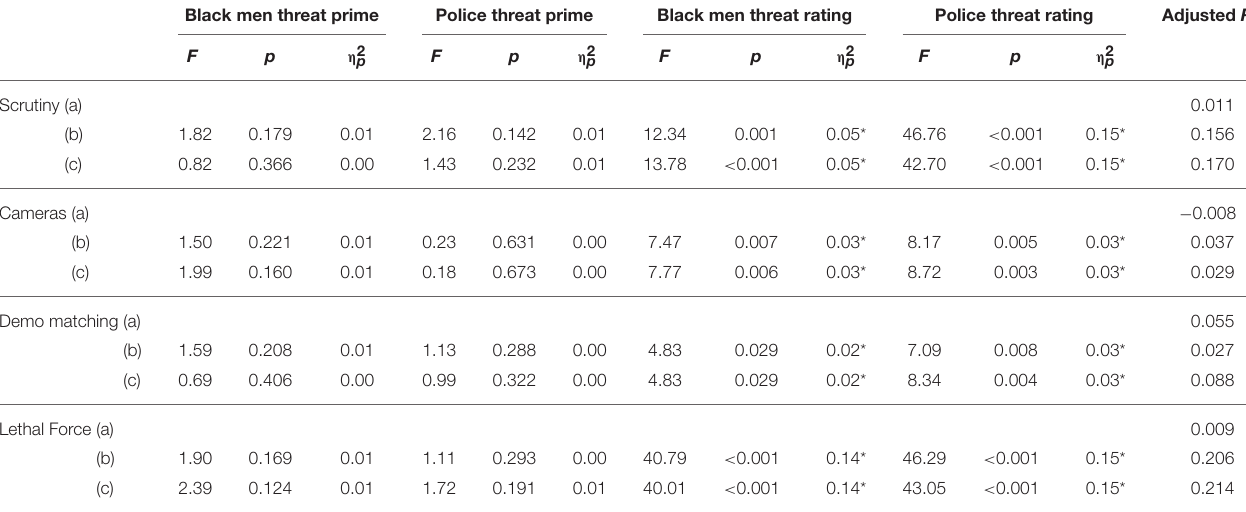
Black men threat